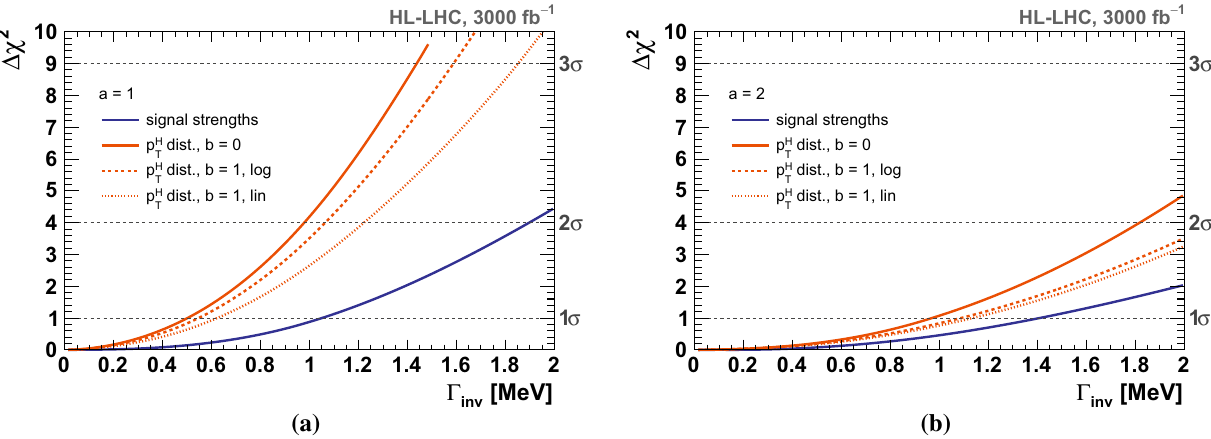
Fig. 3 Constraints on the total width extraction (cid:5) inv ments (orange lines), for the different choices of p H